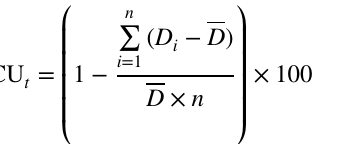
DTI, drip (tape) irrigation; SI, sprinkler irrigation; BI, basin irriga- tion;